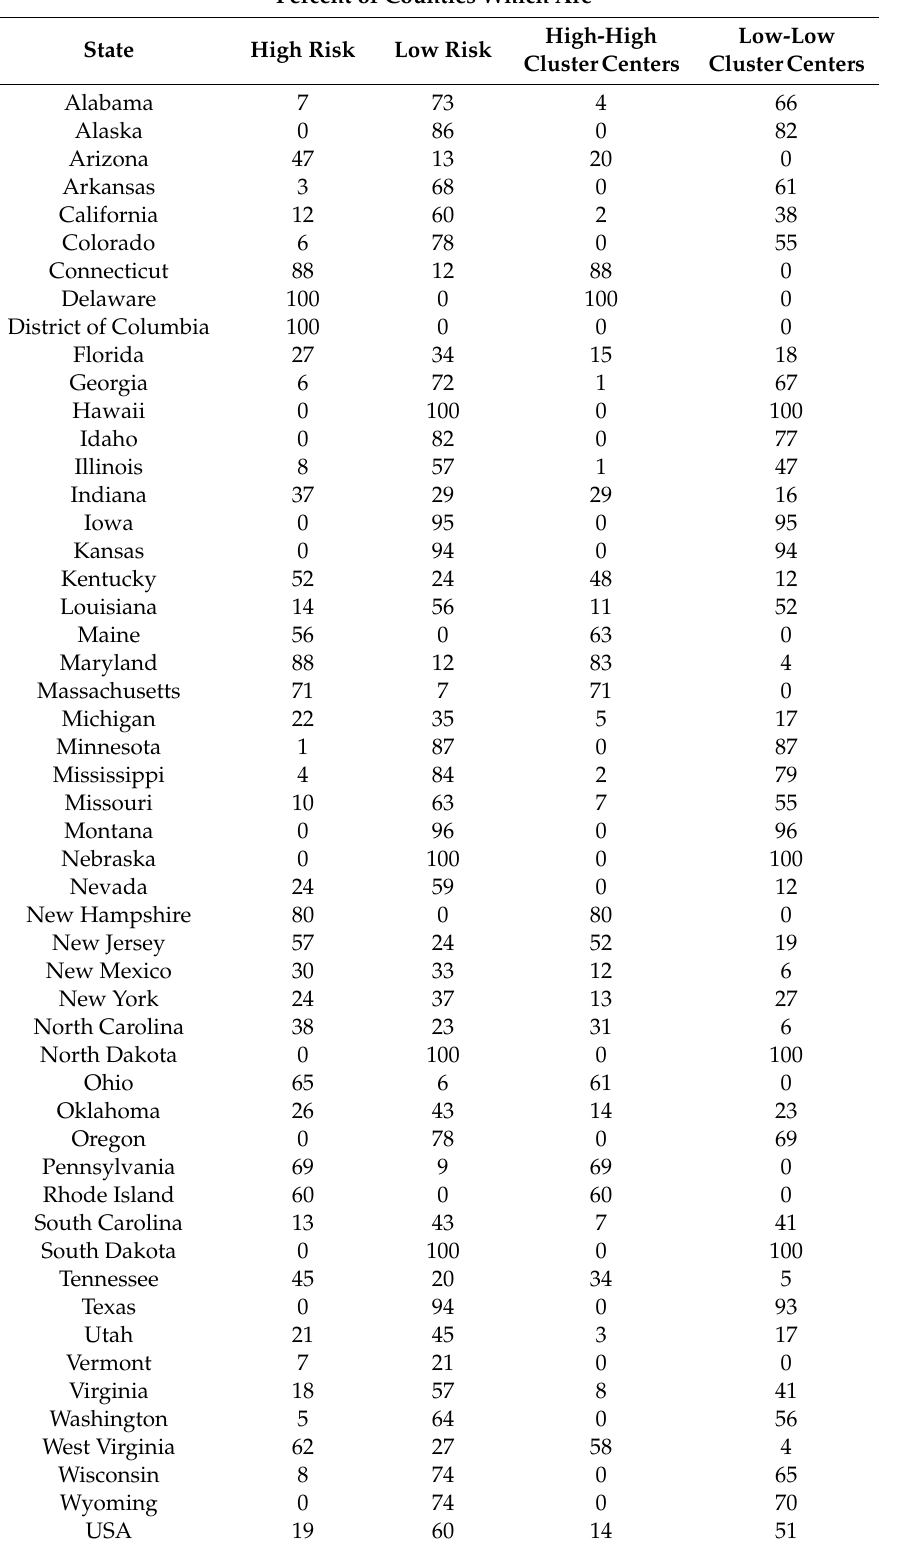
Table 2. Distribution of Risk and Risk Cluster Status across US